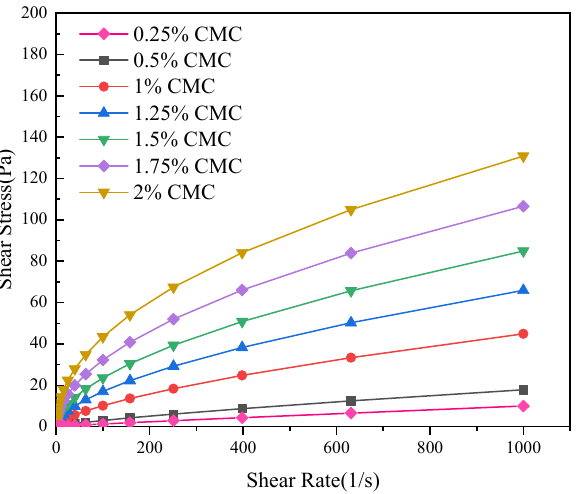
Figure 2. Rheological curves of CMC aqueous solutions with different concentrations.